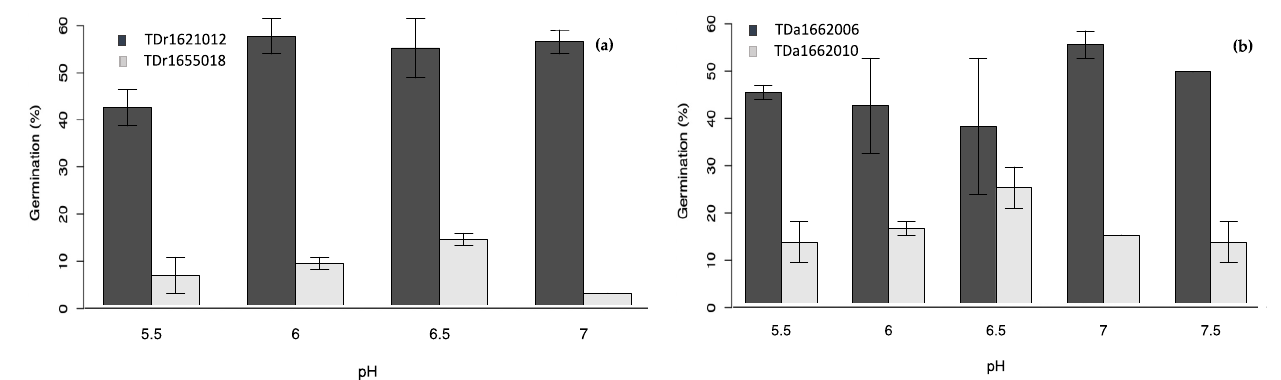
Figure 5. Effects of the medium pH on pollen germination of genotypes of ( a ) D. rotundata , ( b ) D. alata.